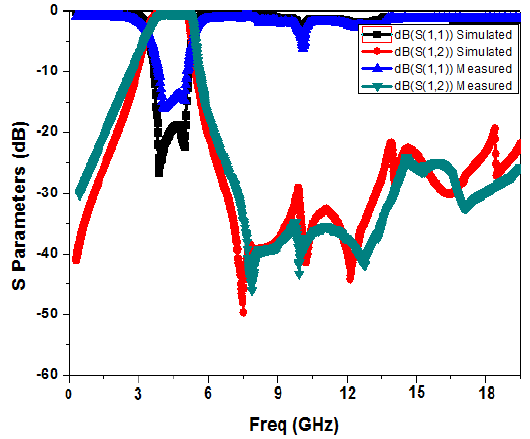
Figure 14. Comparison of simulated and measured results.